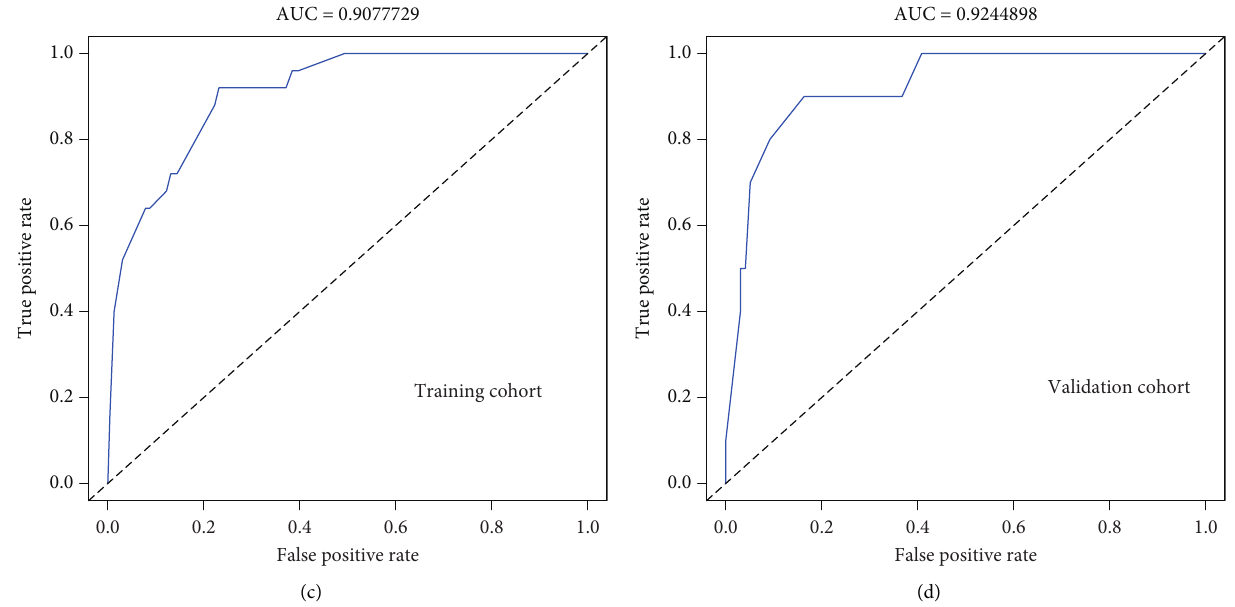
Figure 4: The performance of the nomogram. Calibration plot of the nomogram in (a) the training cohort and (b) validation cohort. The receiver operating characteristic (ROC) curves of the nomogram in (c) the training cohort and (d) the validation